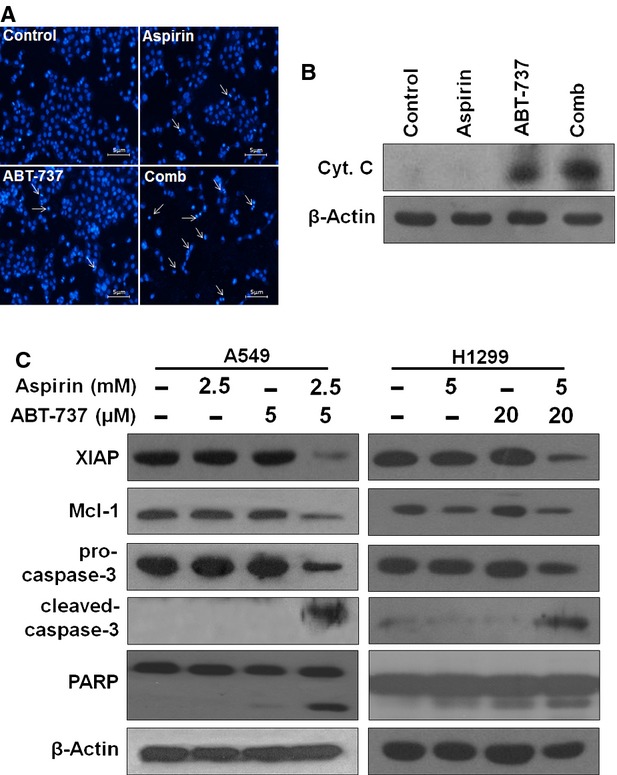
Long-term combination treatment with aspirin and ABT-737 caused activation of various apoptosis related proteins. (A) Aspirin plus ABT-737 induced apoptotic bodies in A549 cells. Nuclear DNA was visualized by DAPI staining; scale bar = 5 μm. (B) Cytochrome c release from mitochondria into cytosol was assessed at 48 hrs in A549 cells incubated with the agents. Cytosolic protein extracts were immunoblotted with specified antibodies for cytochrome c and β-actin. (C) A549 and H1299 cells were exposed to aspirin, ABT-737 or the combination for 48 hrs, after which protein extracts were immunoblotted with specified antibodies for XIAP, Mcl-1, caspase-3, cleaved caspase-3, PARP and β-actin.